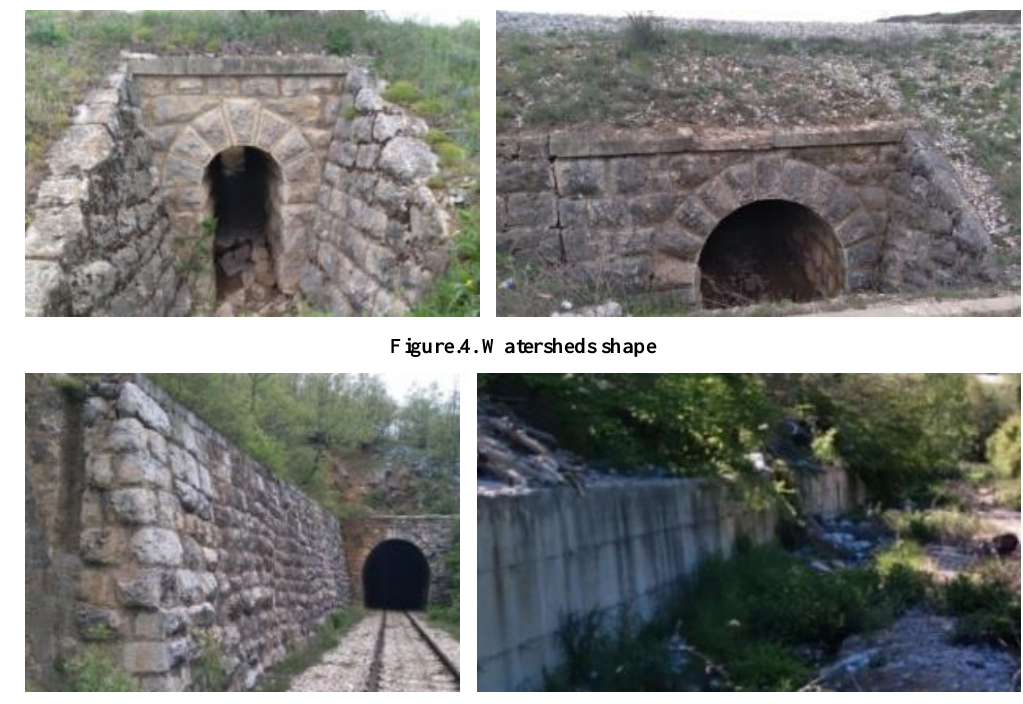
Figure 5. Types of protective walls